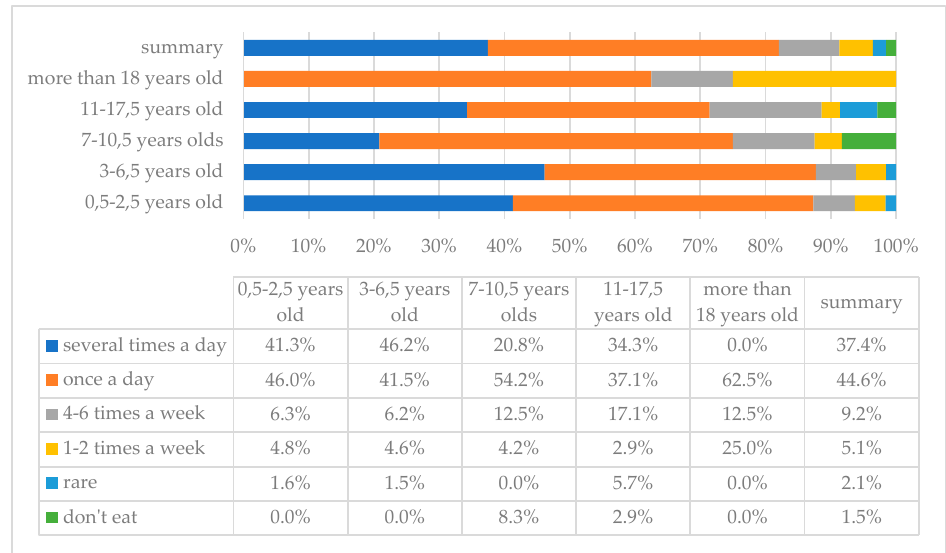
Figure 1. Frequency of vegetable intake in the study group of persons with DS with breakdown by age.